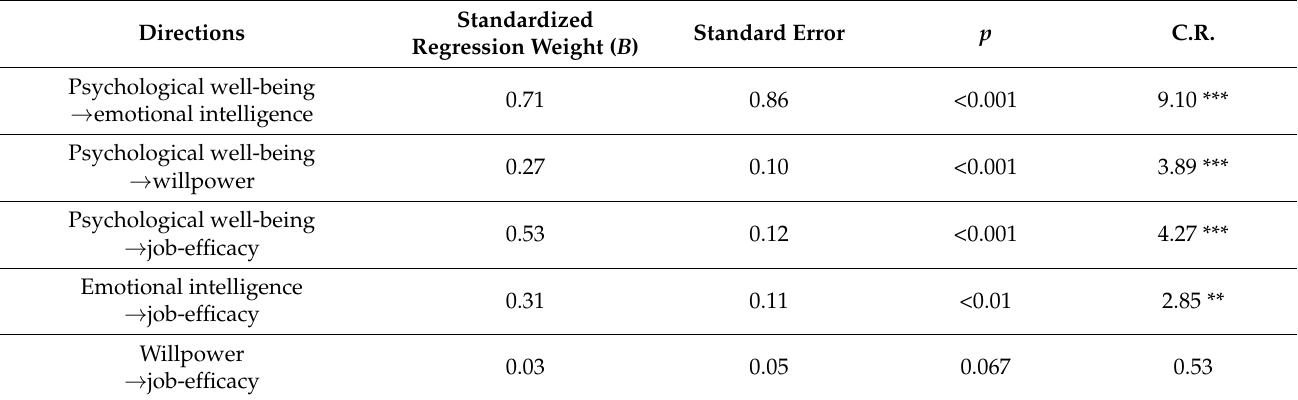
Table 6. Relationships between the human effects of the measurement model.